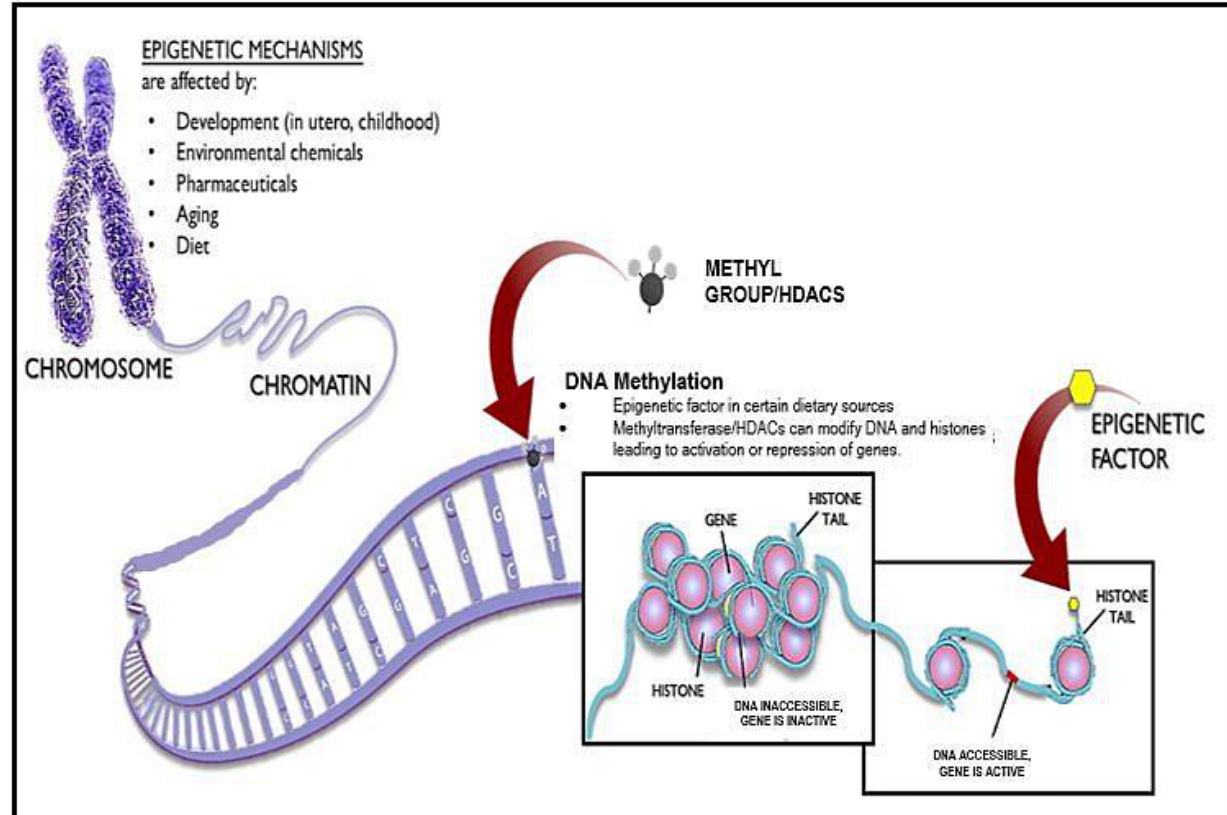
Figure 2. Epigenetic Mechanisms via DNA Methylation and histone modification. Epigenetics can be altered via developmental mechanisms, environmental chemicals, pharmaceuticals, aging, and diet. Some dietary sources can lead to a direct production of DNA methylation, allowing for the overexpression or repression of genes, thereby increasing the aging process.